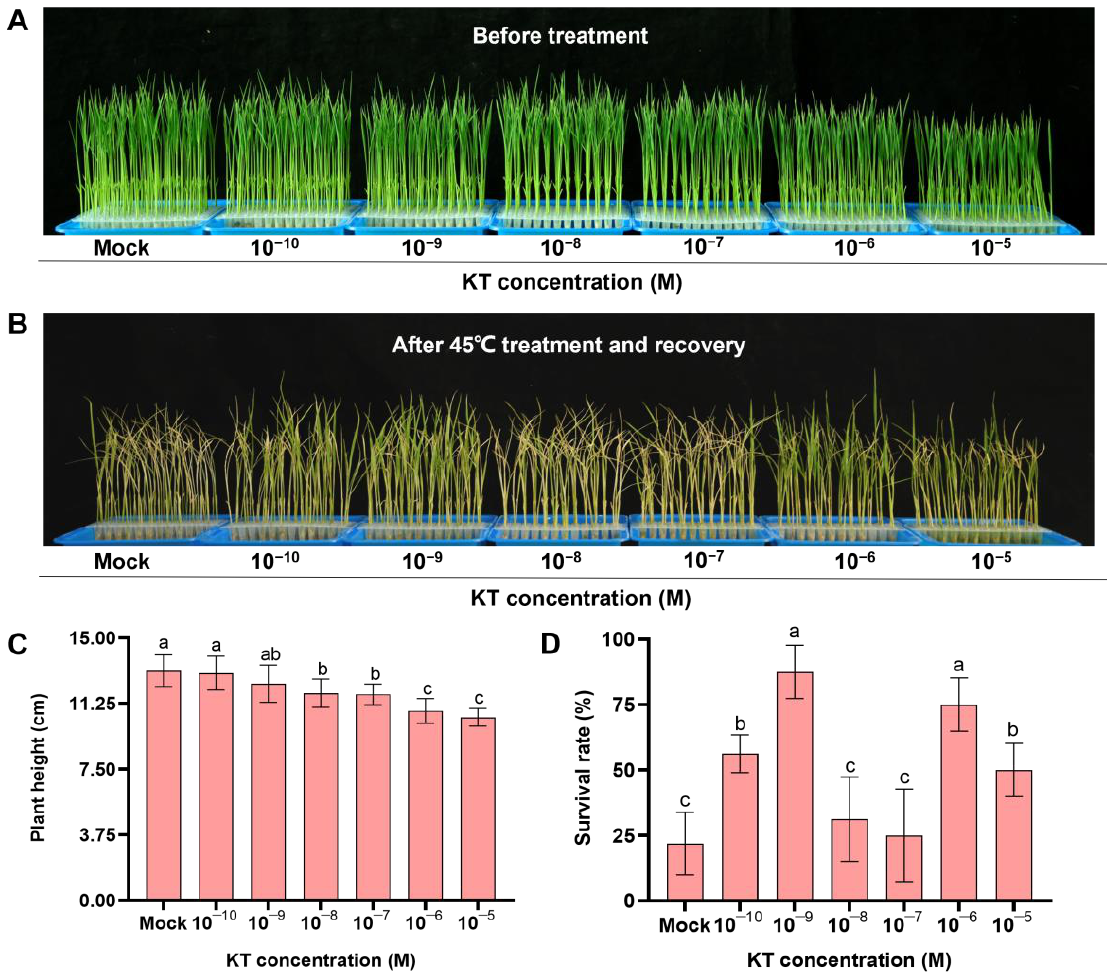
Figure 1. Effect of exogenous application of different concentrations of KT on the survival rate of rice seedlings under heat stress. ( A ) Effect of different concentrations of KT treatment on the growth of ZH11 seedlings at a normal temperature of 28 ◦ C. ( B ) The phenotypes of the different concentrations of KT treatments after high-temperature treatment at 45 ◦ C for 40 h followed by normal temperature recovery at 28 ◦ C for 7 d. ( C , D ) Statistical data of plant height ( C ) and survival rates ( D ) in ( A , B ), respectively. Data are means ± SD. Different lowercase letters show significant differences among treatments analyzed by one-way ANOVA comparison test (n = 8, p < 0.05).